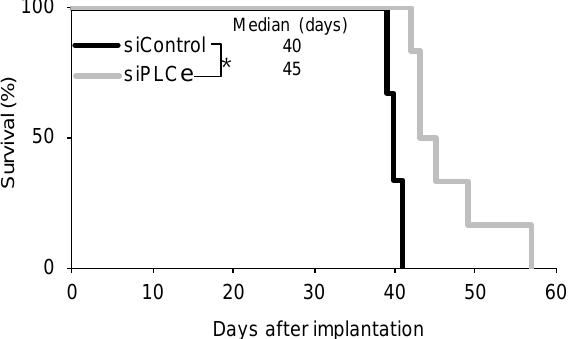
Figure 4. Silencing of PLC ε prolongs survival in the xenograft model. GS-Y03 cells were transiently transfected with siRNA against PLCE1 or siControl for 4 days, after which the cell viability was assessed. An equal number (1 × 10 4 ) of viable cells was then implanted intracranially into each nude mouse. A Kaplan – Meier analysis shows the survival curves for mice ( n = 6 for each group). * p < 0.05 vs. siControl-transfected cells by the Log-rank test.